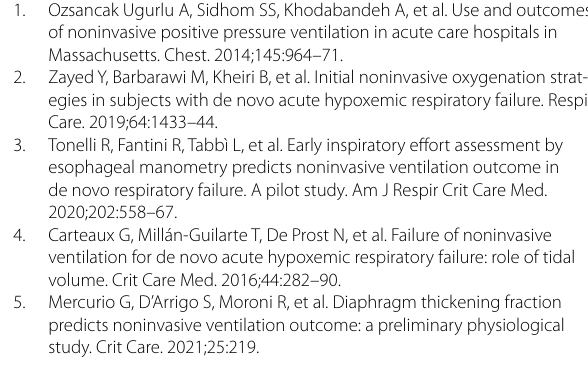
Table 3 Comparisons in predictive power between ROX index, PaO